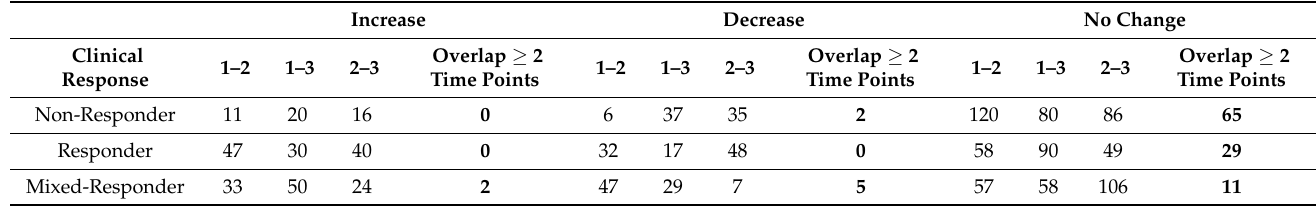
Table 6. Patterns of classical, high abundant extracellular vesical associated proteins that changed in abundance over time. Increase